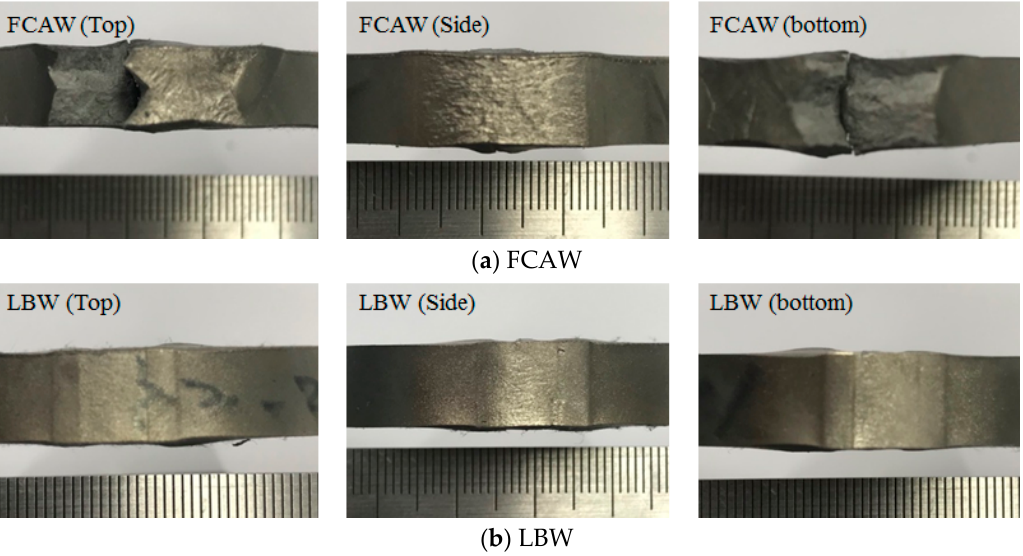
Figure 10. Comparison of bending test results. ( a ) 3-points bending specimen fracture shape with FCAW; ( b ) 3-points bending specimen fracture shape with LBW.